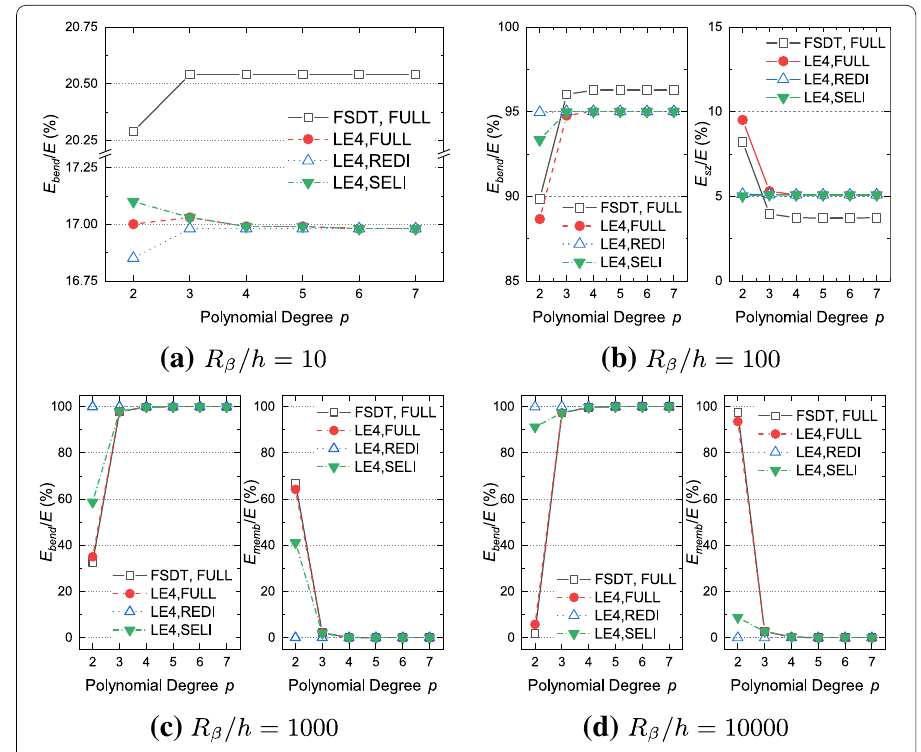
Fig. 15 Variation of relevant energy components for each aspect ratio with respect to the polynomial degree of FE models for the three-layered cylindrical panel under bending, for various radius-to-thickness ratio R β / h